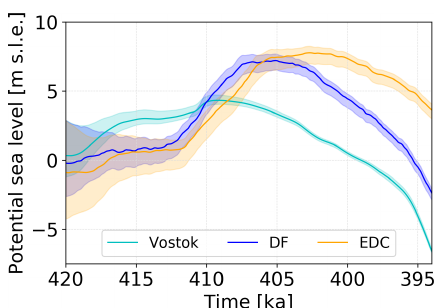
Figure 6. Sensitivity of the AIS response to CFEN GI recon- structions (Vostok, DF, EDC) between 420 and 394ka with uncer- tainty bands from four distinct initial ice sheet starting geometries (gmt1–3 and respective CFEN member), expressed in contribution to global mean sea level [ms.l.e.]. Solid lines show the mean of each common-forcing ensemble member, while the colour filling shows the spread given by the different starting